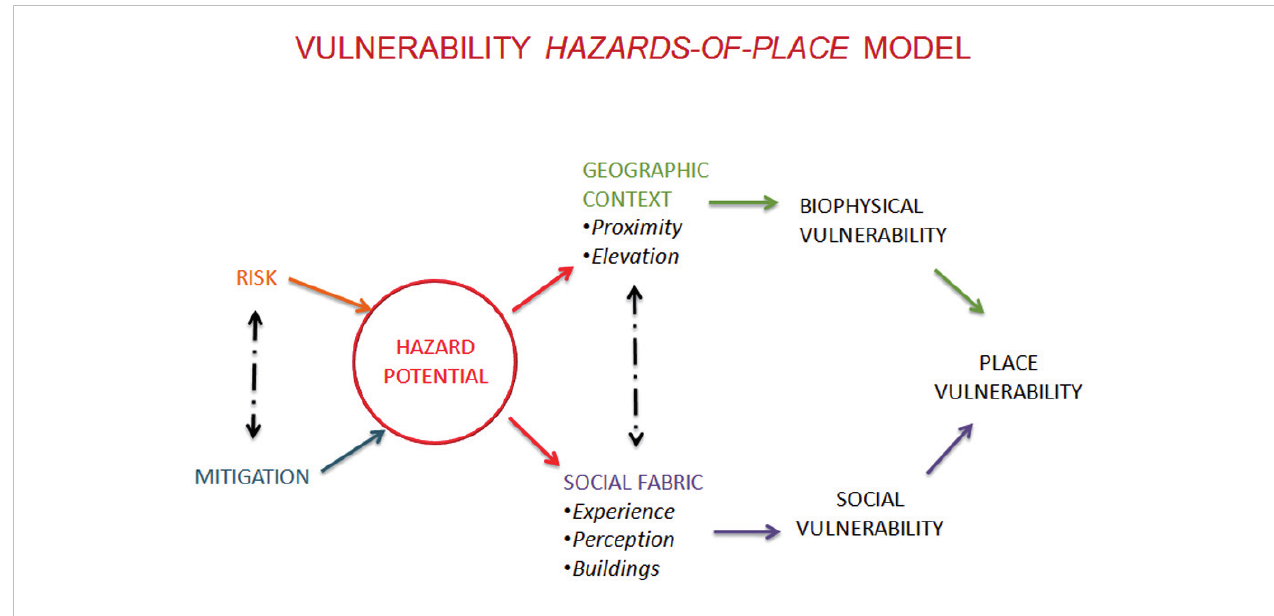
Figure 1. The ‘Vulnerability Hazards-of-Place Model’ of Cutter [1996] shows the structure and social dynamics in facing a hazard potential.